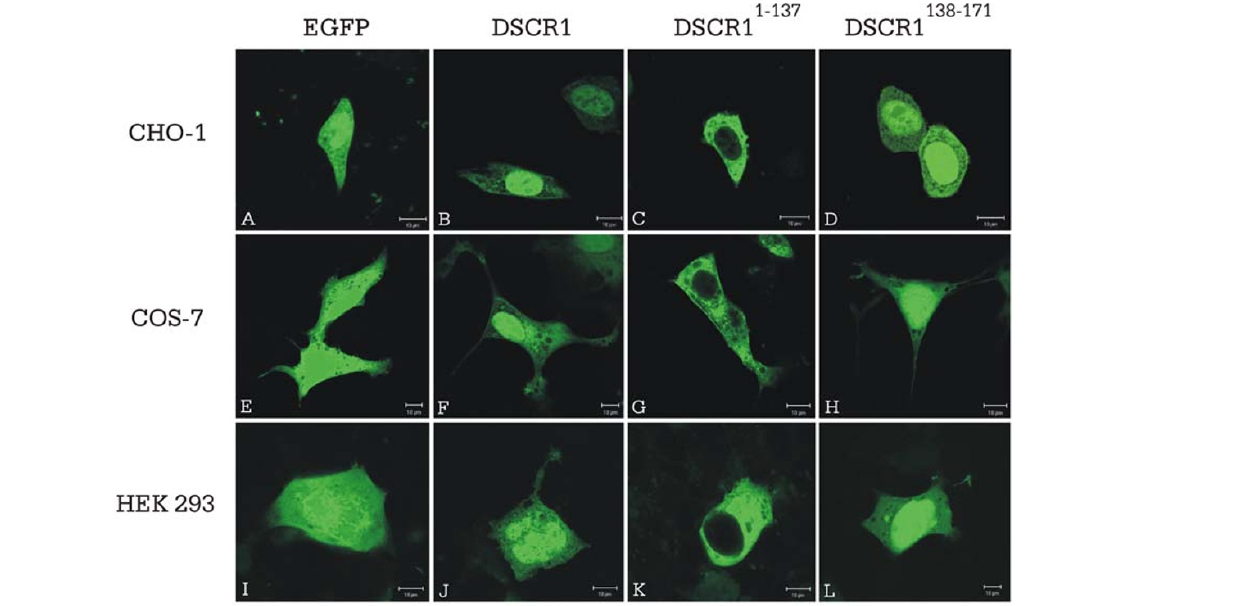
Figure 2 Confocal laser scanning microscope images of both DSCR1 and DSCR1-mutant expression in CHO-1 (line 1, A-D), COS-7 (line 2, E-H) and HEK 293 cells (line 3, I-L). Subcellular location of: EGFP (A, E, I), DSCR1 (pEGFP- DSCR1)(B, F, J), DSCR1 1–137 (C, G, K) and DSCR1 138–171 (D, H, L). The different mutational constructions are included in the section on material and methods and analyzed in detail in the results section. Scale bars are indicated in the